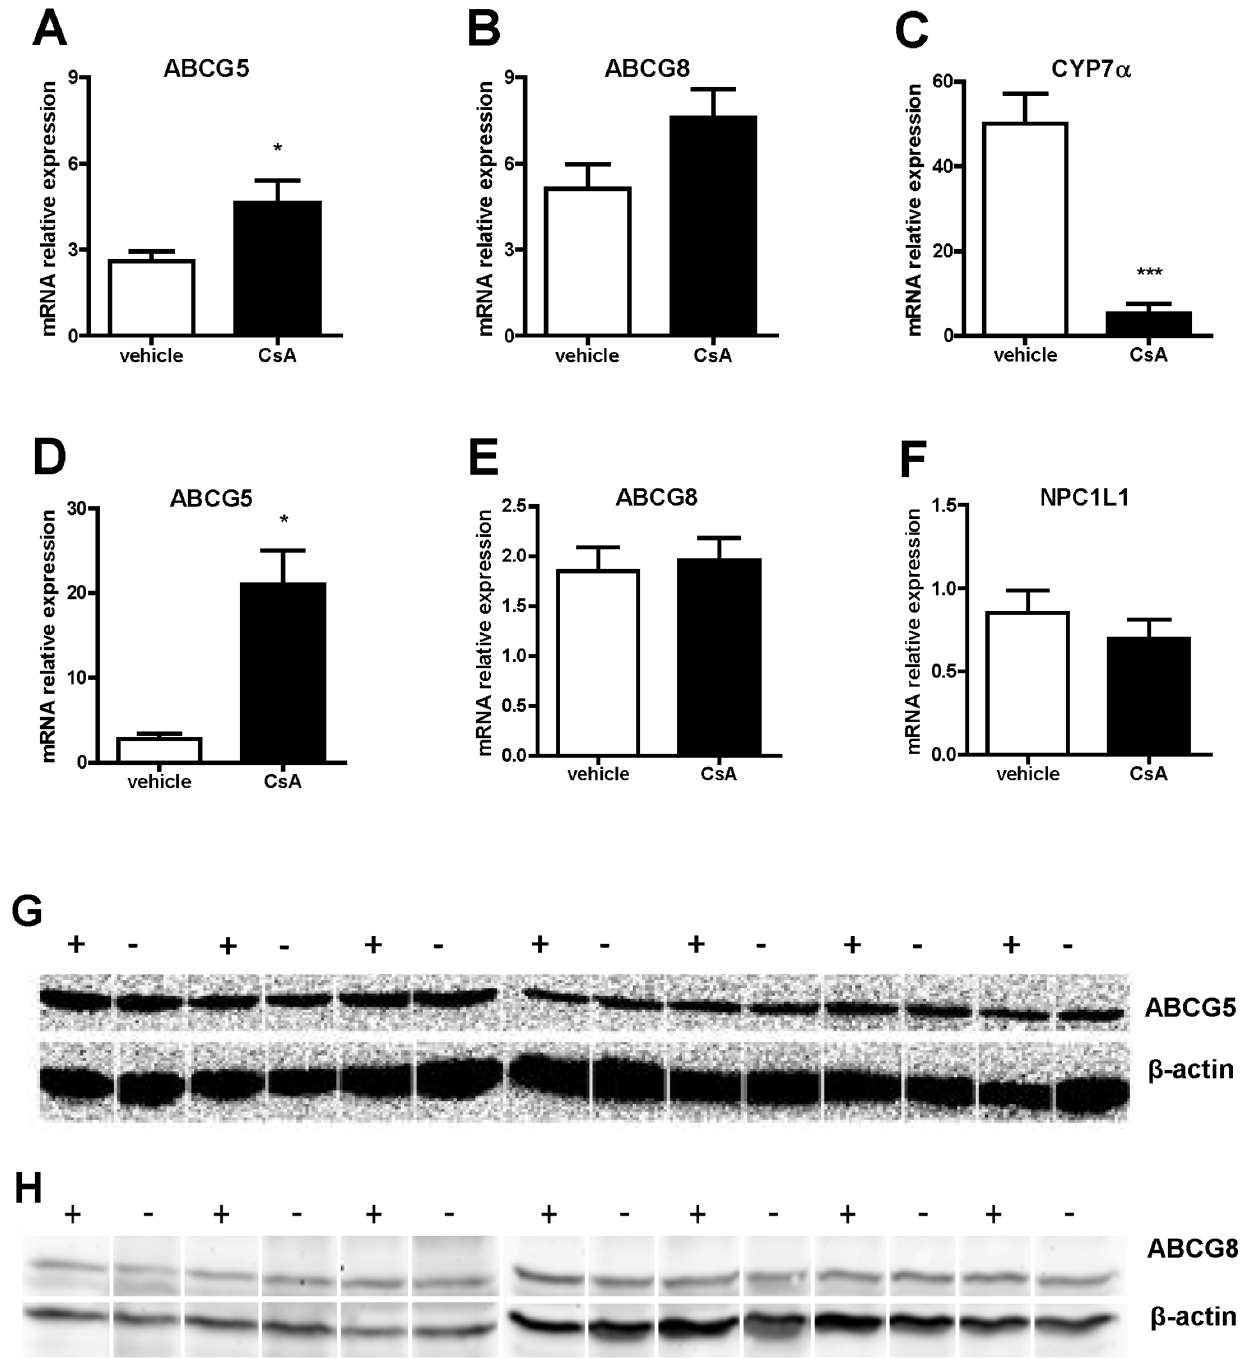
Figure 6. CsA treatment effect on sterol transporters expression in vivo. C57BL/6 mice were treated with CsA as described in Methods. After the sacrifice, liver and small intestine were collected to isolate RNA. Abcg5 , Abcg8 , Cyp7 a and Npc1l1 mRNA was quantified by qRT-PCR in liver (A,B,C) and intestine (D,E,F) respectively. Results were normalized against Hprt (shown); normalization against b -actin, or the average of them gave similar results (not shown). G, H: Western blotting analysis was performed on hepatic lysates prepared as described in the Methods section. Lanes (–): mice treated with vehicle. Lanes ( + ): mice treated with CsA. Data are presented as means 6 SD. *p , 0.05 and ***p , 0.001 vs vehicle. doi:10.1371/journal.pone.0071572.g006 limiting step of cholesterol conversion into bile acids. The macrophage RCT through the inhibition of this key enzyme in cholesterol catabolism. Although the impairment of CYP7 A is observed, significant reduction of hepatic expression upon the pharmacological treatment with CsA is consistent with previous sufficient to explain the reduced neutral sterol excretion in the bile reports [23] and apparently suggest that the drug may impair and intestine, we can not exclude that CsA may affect other